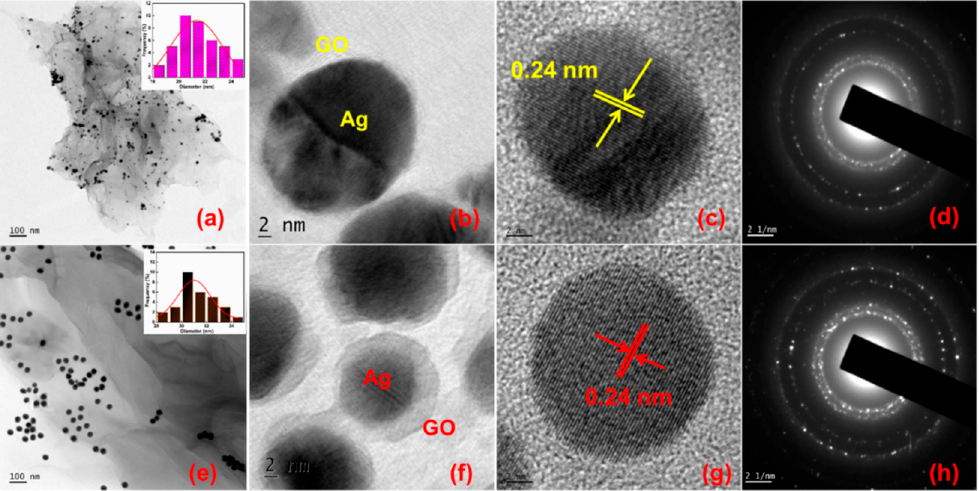
Figure 4. TEM and HRTEM images of ( a – c ) Ag-GO@355 nm, ( e – g ) Ag-GO@532 nm samples synthesized at 15 min ablation time and ( d , h ) selected area electron diffraction (SAED) patterns of Ag-GO@355 nm and Ag-GO@532 nm samples, respec- tively.